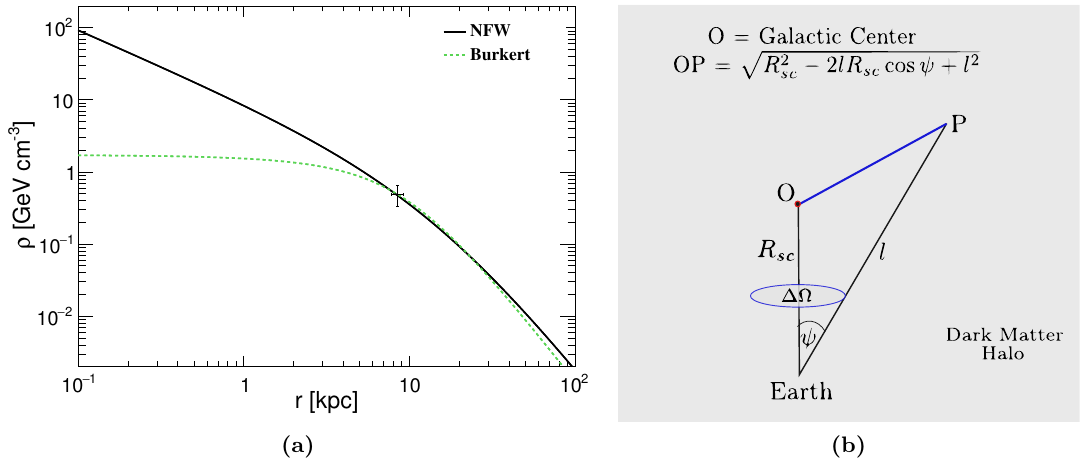
Figure 1. (a) Distribution of the dark matter density in the Milky Way galaxy for the NFW (black solid line) and Burkert pro(cid:12)les (green dashed line). The observational bounds on local dark matter density ( (cid:26) sc ) and the solar radius ( R sc ) and their 2 (cid:27) uncertainties are indicated [4, 65]. (b) A schematic diagram of some part of the Milky Way dark matter halo. The Galactic center (GC) is denoted by O and R sc is the distance between the Earth and the GC. The parameter l is the distance between point P and the Earth. The angle made at the Earth by points P and O and the corresponding solid angle are denoted by and (cid:1)(cid:10)